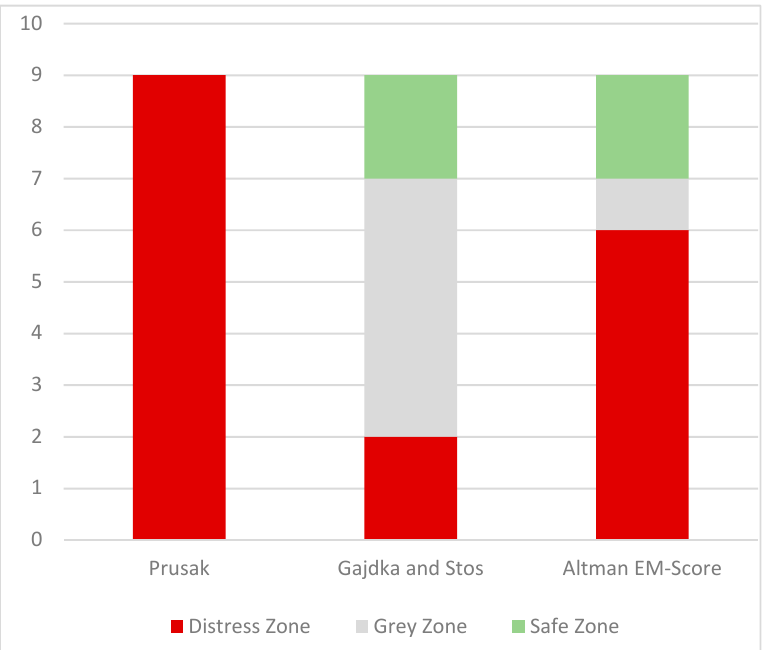
Figure 2. The classification of companies according to the discriminant models in the first half of 2019.